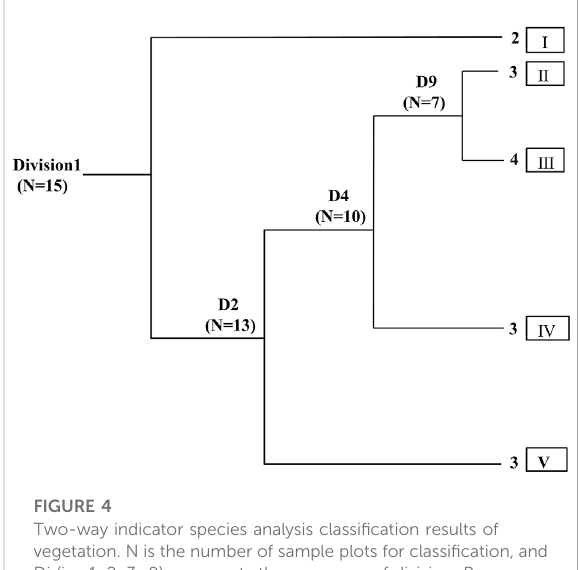
FIGURE 5 Distributioncharacteristicsofplantdiversityinthe fi vesample plots. Different lowercase letters indicate signi fi cant differences ( p <